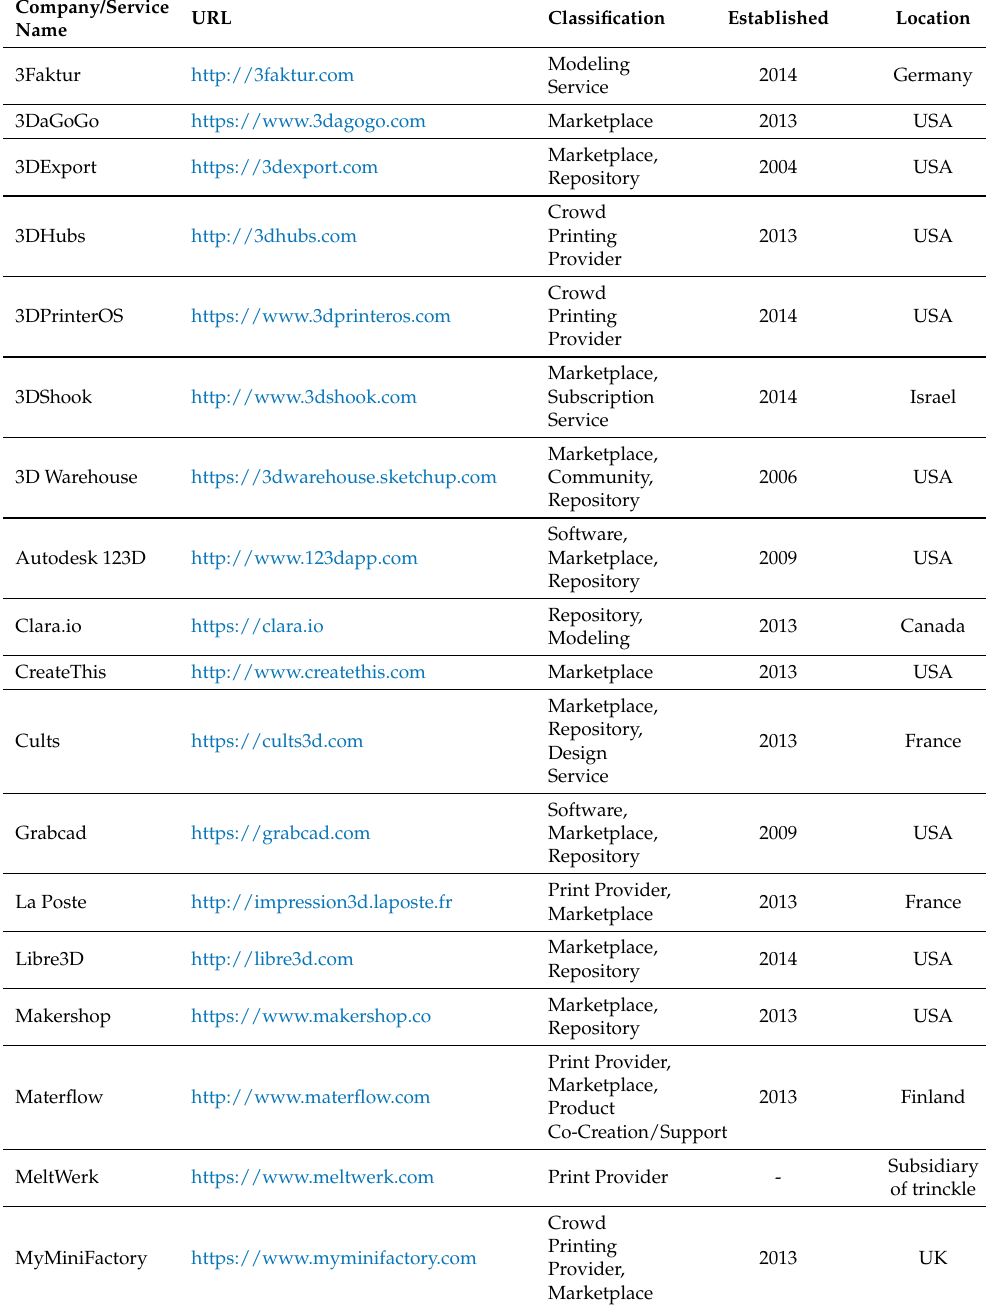
Table 1. 3D printing platforms and services included in this study—Part